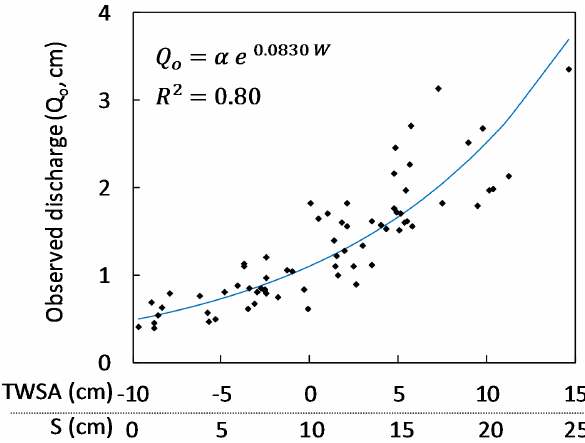
Figure 2. Storage–discharge for the Mississippi River basin (site 12) based on Eq. (3) and an assumed S o value of 10cm, which is arbitrarily selected to illustrate the effects on Q – S relation- ships, where W represents storage in GRACE TWSA units ( x axis, TWSA, in cm) or absolute units ( x axis, S , in cm) and α is 1.101 if W is TWSA or 0.4934 if W is S